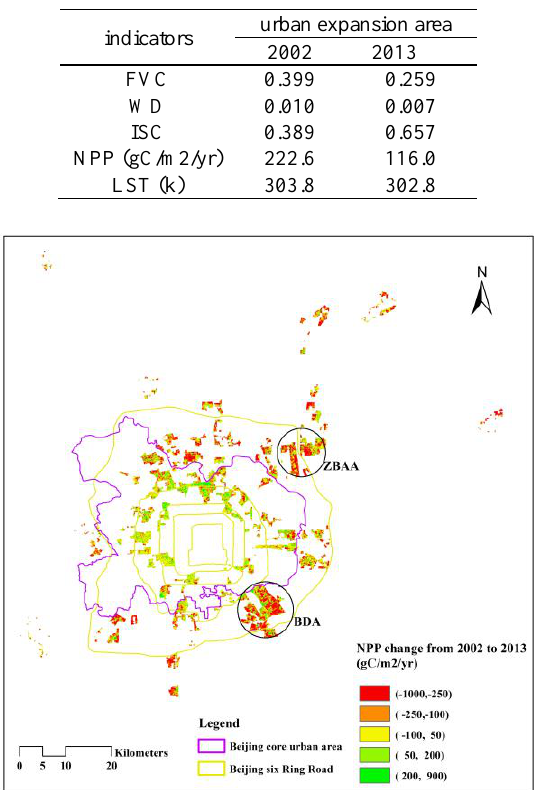
40508 tons of carbon loss in Beijing urban sprawl area . Table 1. Ecological environment change in urban sprawl areas